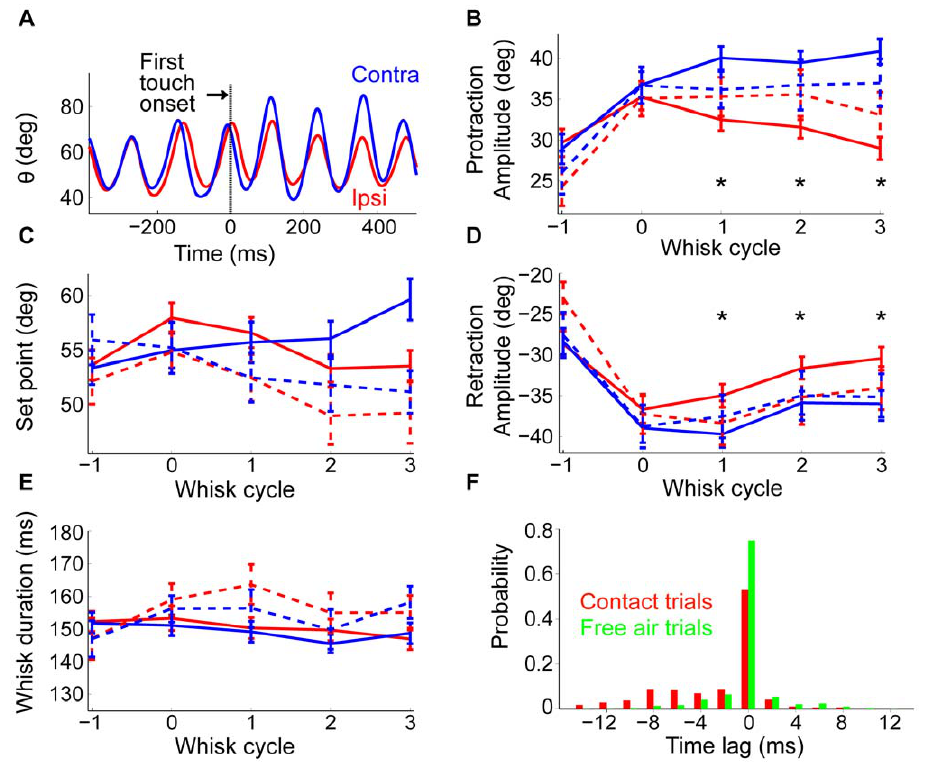
Figure 7. Whisking amplitudes, durations, and set-points after first touch. A. Whisking angle of the ipsilateral C1 whisker (red) and contralateral C1 whisker (blue). Onset of the first touch in a trial is marked by a vertical line. B. Protraction amplitudes of whisker C1 as a function of whisk cycle, around first touch (red, blue) or first pseudo touch (dotted red, dotted blue). Ipsilateral C1 whisker (red, dotted red) and contralateral C1 whisker (blue, dotted blue). The most rostral untrimmed whisker C2 is touching the pole (the rare trials where whisker C1 also touched the pole in any of the first contacts were excluded from this analysis). Whisk cycle 0 is the first whisk with touch (or pseudo touch) in the trial. Asterisks indicate significant difference between ipsi and contralateral sides. We note that since the number of pseudo-touches was smaller than the number of real contacts, the error bars in the pseudo-touch trials were usually larger. C. Set point around touch as a function of whisk cycle. D. Same as B, but for retraction amplitude (negative value indicates retraction). E. Whisk duration around first touch. F. Probability of time-lags for contact and free-air trials.